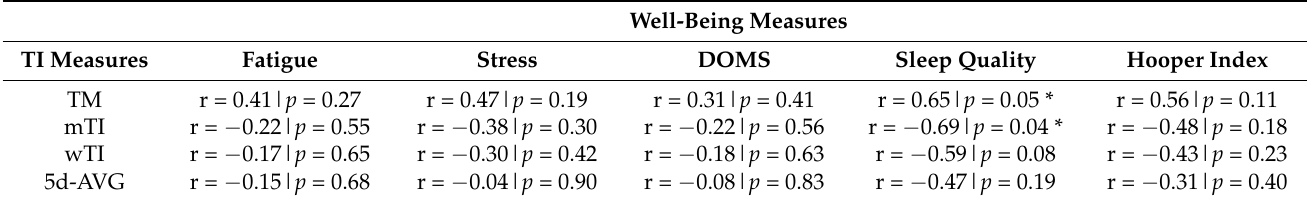
Table 4. Correlation between training intensity and well-being variations.